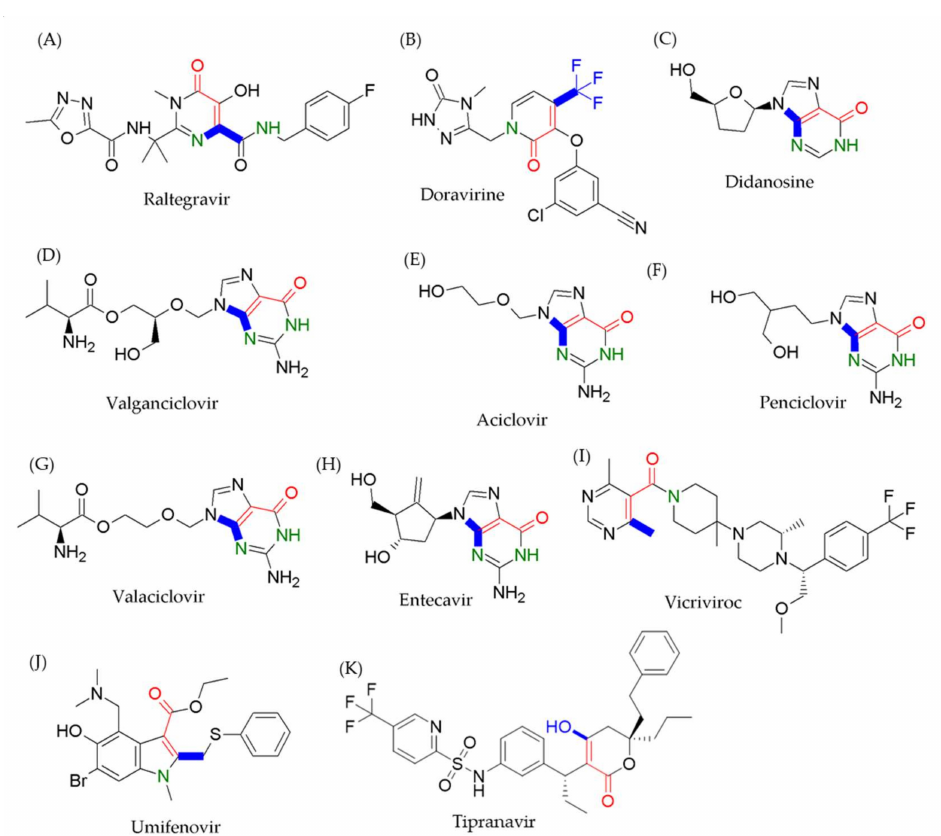
Figure 5. Both steric hindrance and nitrogen lone-pair conjugation disrupt the Michael addition acceptors. The structures of ( A ) raltegravir, ( B ) doravirine, ( C ) didanosine, ( D ) valganciclovir, ( E ) aciclovir, ( F ) penciclovir, ( G ) valaciclovir, ( H ) entecavir, ( I ) vicriviroc, and ( J ) umifenovir rarely undergo Michael addition because of steric hindrance (blue bond) and nitrogen lone-pair (green nitrogen) in the vicinity of the Michaela acceptor moiety (red bonds and atoms), and ( K ) tipranavir does not undergo Michael addition reaction solely because of the steric hindrance (blue